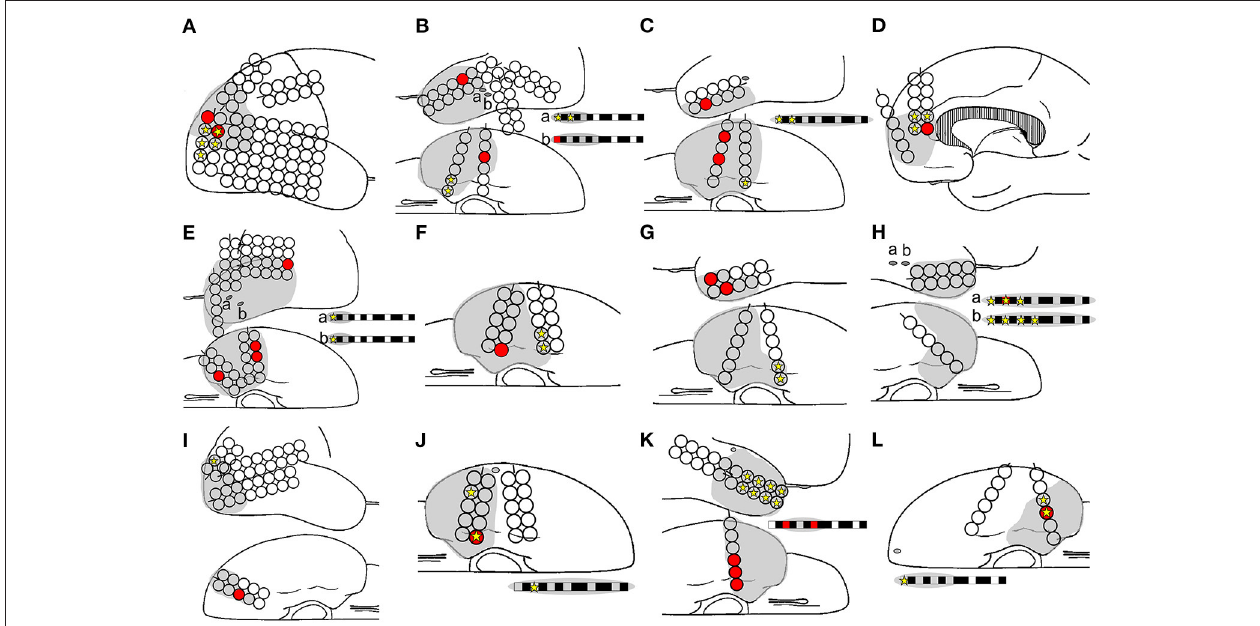
FIGURE 5 | Relationships among ripple onset, ictal onset, and the resection area. The ripple onset electrode (filled red circle and box), ictal onset electrode (filled yellow star), and resection area (gray area) are shown. Letters (A–L) in the schema represent Patients 1–12. The ripple onset channel was within the resection area in all the patients. The ripples and ictal channels were identical for only three patients: Patients 8 (H) , 10 (J) , and 12 (L)